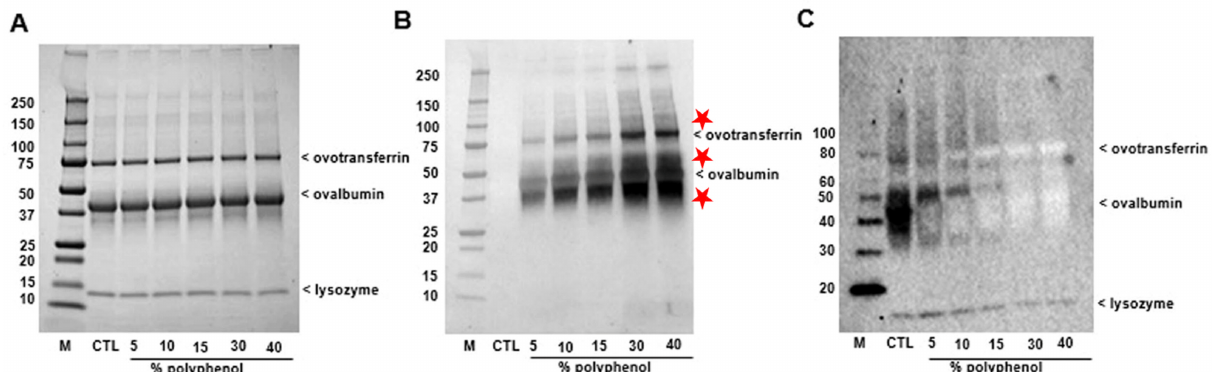
Figure 1. Protein distribution visualized by Coomassie Brilliant Blue staining (CBB), nitroblue tetrazolium (NBT) staining, and IgE binding capacity. ( A ) SDS-PAGE of unmodified egg white protein (CTL) or egg white protein-polyphenol aggregate particles containing 5, 10, 15, 30, and 40% polyphenols and stained with CBB; ( B ) Staining of green tea polyphenol-bound egg white proteins by NBT, following SDS-PAGE and subsequent electrophoretic transfer to a PVDF membrane; ( C ) corresponding Western blot. Pooled human plasma from 7 egg white-allergic individuals was used to bind antigens on the membrane. Egg white-specific IgE levels ranged from 15.4 to 100 kU L −1 as determined via ImmunoCAP (Phadia, Uppsula, Sweden). Biotinylated goat IgG anti-human IgE was used as the secondary antibody and NeutrAvidin HRP conjugate and substrate were used for signal production. M: molecular weight marker (kDa); CTL: control (unmodified egg white protein). Approximate locations for egg white allergens are indicated. Gray scale was used for gels and membranes and contrast was optimized to improve